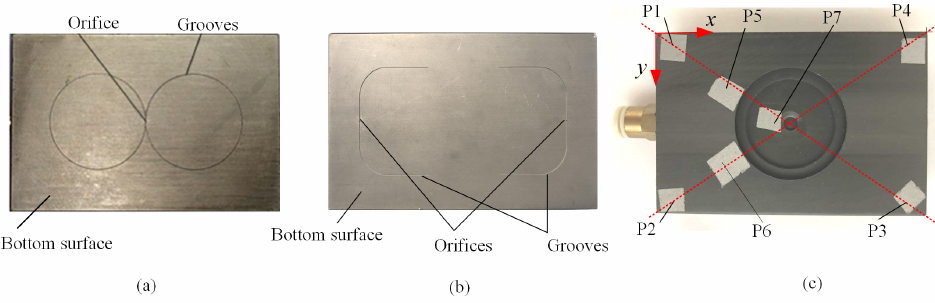
Figure 6. The examined restrictors: ( a ) double-ring-grooved; ( b ) double-U-grooved; and ( c ) upper